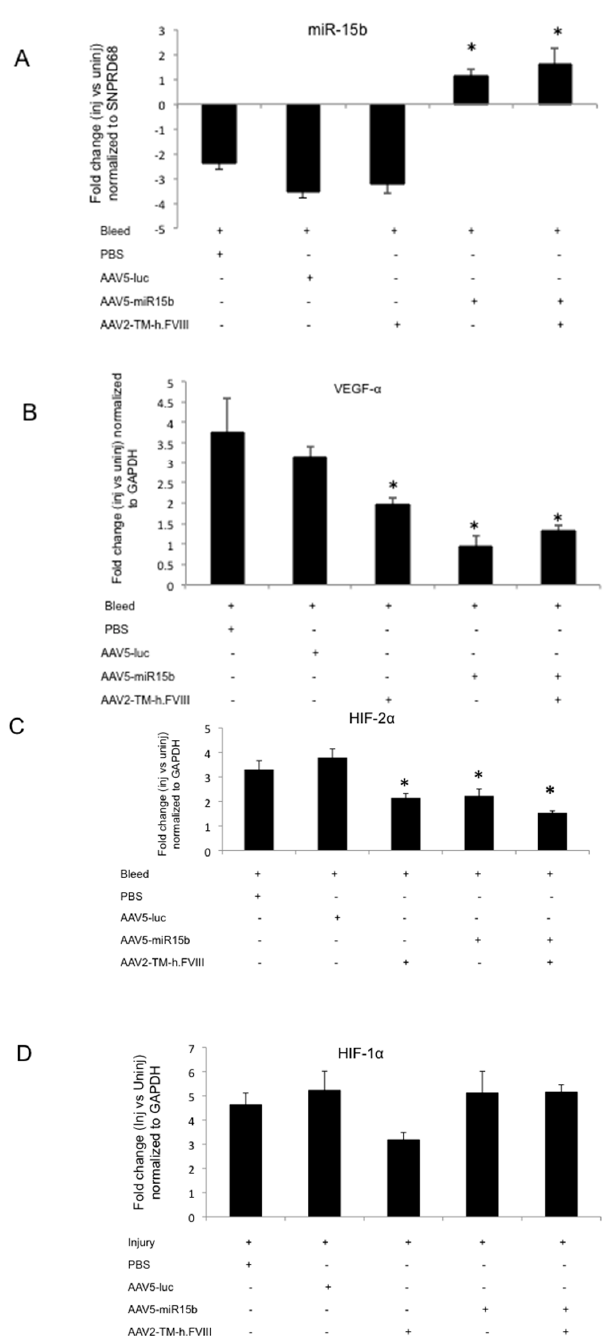
Figure 5. miR-15b over-expression in the murine knee joints after four episodic bleeds downregulates vascular epithelial growth factor α (VEGF- α ) and hypoxia inducing factor 2 α (HIF-2 α ) levels but not HIF-1 α in the injured joints. Groups of mice ( n = 4 to 5) were administered with either PBS or AAV5-miR-15b or AAV5-luc vectors (intra-articular) and/or AAV2-TM-h.FVIII (intravenous) vectors. After four episodic bleedings in the left knee joints, qPCR was performed on joint RNA for various targets: ( A ) miR-15b; ( B ) HIF-1 α ; ( C ) VEGF- α ; and ( D ) HIF-2 α . * p < 0.05 when compared to the AAV5-Luc treated injured animals. GAPDH: Glyceraldehyde 3-phosphate dehydrogenase.